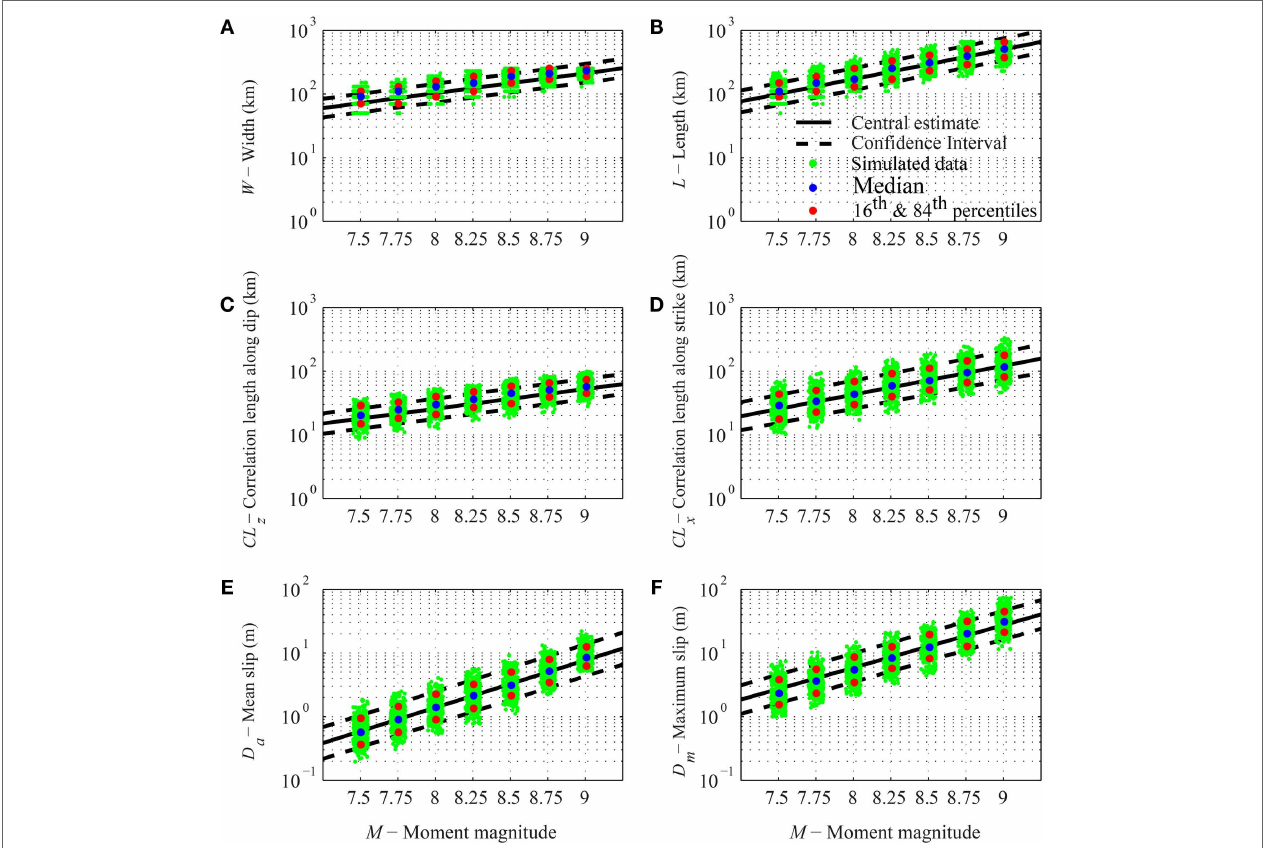
FIGURE 4 | Scaling relationships for tsunamigenic earthquakes . (A) Rupture width versus moment magnitude. (B) Rupture length versus moment magnitude. (C) Correlation length along dip versus moment magnitude. (D) Correlation length along strike versus moment magnitude. (E) Mean slip versus moment magnitude. (F) Maximum slip versus moment magnitude. The simulated values (green dots) and the corresponding percentiles (colored circles) are also